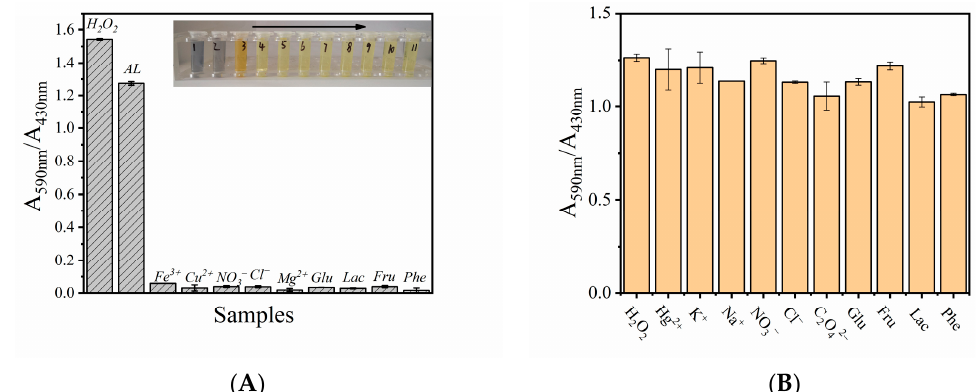
Figure 7. ( A ) Selectivity tests with the 10.0 mM of interferents (Fe 3+ , Cu 2+ , NO 3 − , Cl − , Mg 2+ , Glu, Lac, Fru, Phe, and diluted AL) of the MVCM-based assay system with 20 μ g/mL of the MVCM, 11.25 μ M PR, 30 mM NH 4 Br, and an acetic acid buffer (pH = 4.5). Inset: Related color changes. ( B ) Interference tests of the MVCM-based assay system containing the MVCM, acetic acid buffer, PR, NH 4 Br, H 2 O 2 , and interferents (Hg 2+ , K + , Na + , NO 3 − , Cl − , C 2 O 42 − (five times higher than H 2 O 2 ), Glu, Fru, Lac, and Phe). The absorbance was monitored at 590 nm and 430 nm after incubating at 37 °C for 50 min. Error bars represent the standard deviation of three trials.